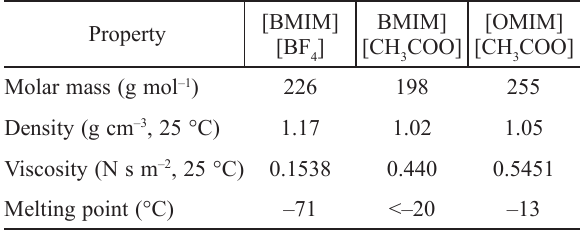
Table 2 – Some properties of ILs at 25 °C Property